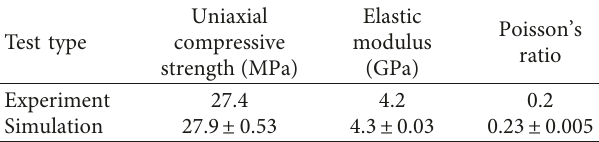
Figure 3: Shear displacement and stress curves.